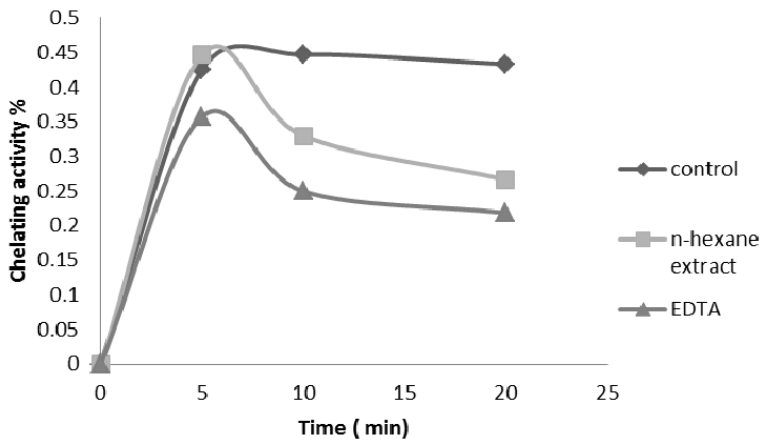
Figure 4. Formation of the Fe 2+ -ferrozine complex of n -hexane extract of the leaves of P.auritum and EDTA. Values are mean ± SEM and significantly p < 0.05.